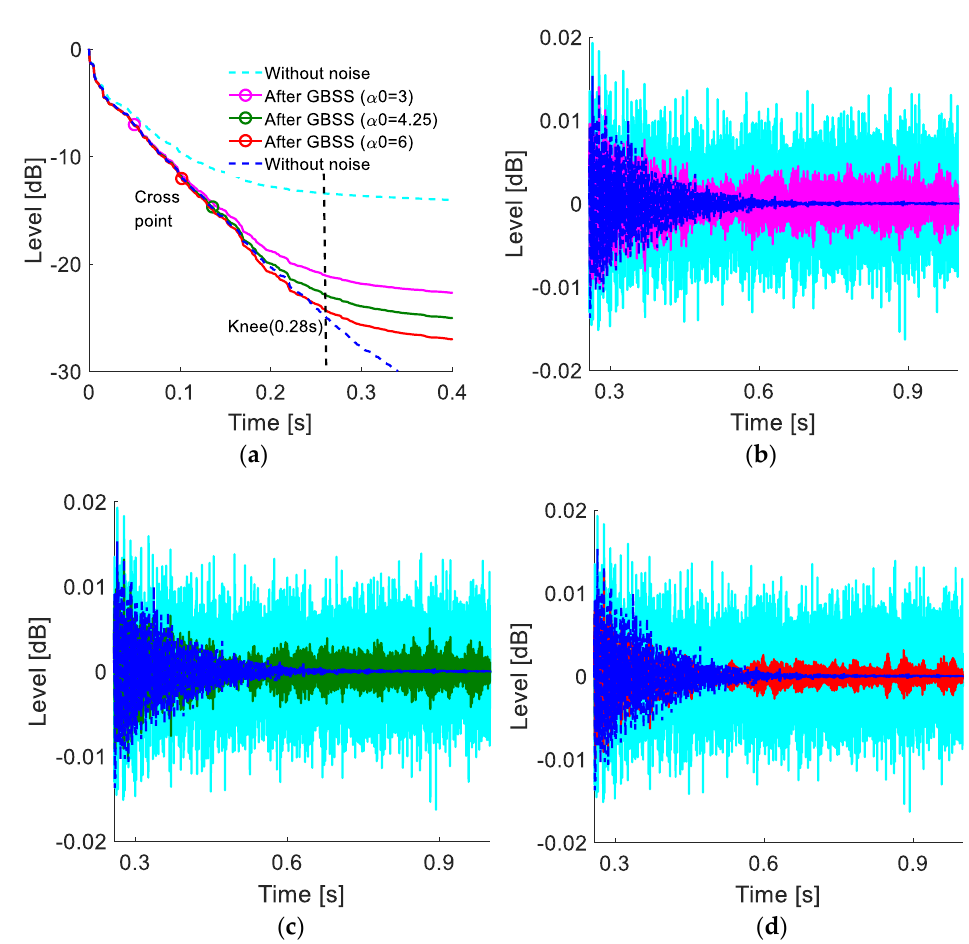
Figure 4. De-noising effects at the knee with various factors of α 0 . ( a ) Comparison of the dynamic range at the cross point. ( b – d ) Comparison of the de-noised RIRs to the reference RIRs at the knee: factor of ( b ) 3, ( c ) 4.25, and ( d ) 6 applied.